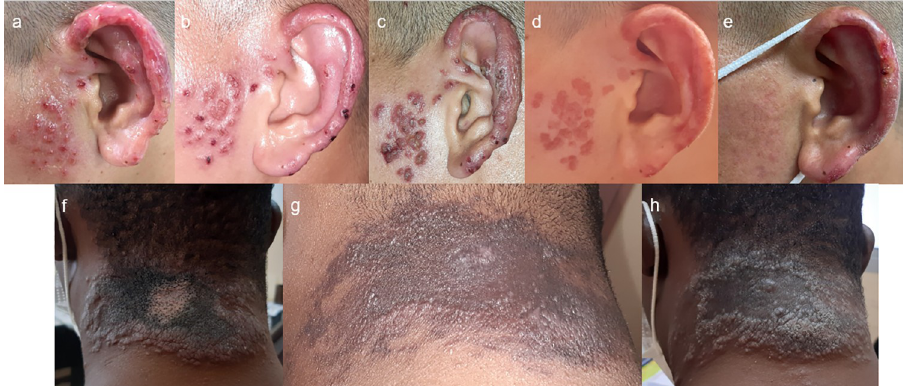
Fig 3. Clinical evolution of patient 2 and 3, CEFE outbreak, French Guiana, 2020: patient 2 presented an ulceration on the ear and papules of the adjacent cheek ( 3a ); improvement after pentamidine ( 3b ) followed by relapses ( 3c ), requiring a course of amphotericin B, then a second scheme in association with miltefosine ( 3d ), with partial response ( 3e ) followed by a relapse. The patient was then treated with 3 weeks of meglumine antimoniate. Patient 3 presented a similar history with a pseudo-verrucous plaque of the neck ( 3f ), which first improved ( 3g ), and then relapsed ( 3h ) motivating a further line of treatment with amphotericin B, amphotericin B and miltefosine then finally meglumine